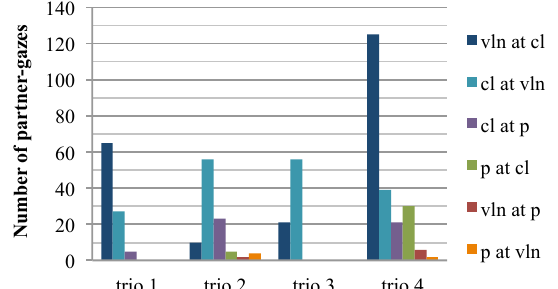
Figure 2. Number of partner-gazes for all four run-throughs in total. Partner-gazes take place from violin to clarinet (vln at cl), from clarinet to violin (cl at vln), from clarinet to piano (cl at p), from piano to clarinet (p at cl), from violin to piano (vln at p), and from piano to violin (p at